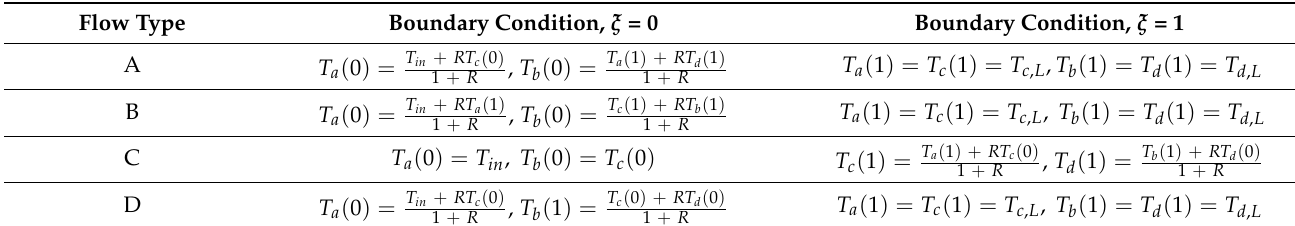
Table 2. Boundary conditions of various configurations for Type A to Type D.